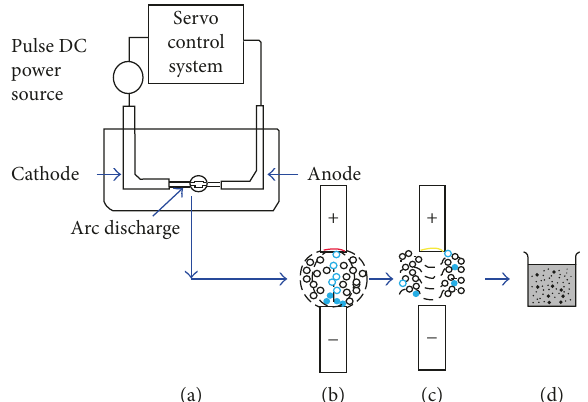
Figure 1: The color of the nanosilver particle suspension changed from yellow to dark brown.